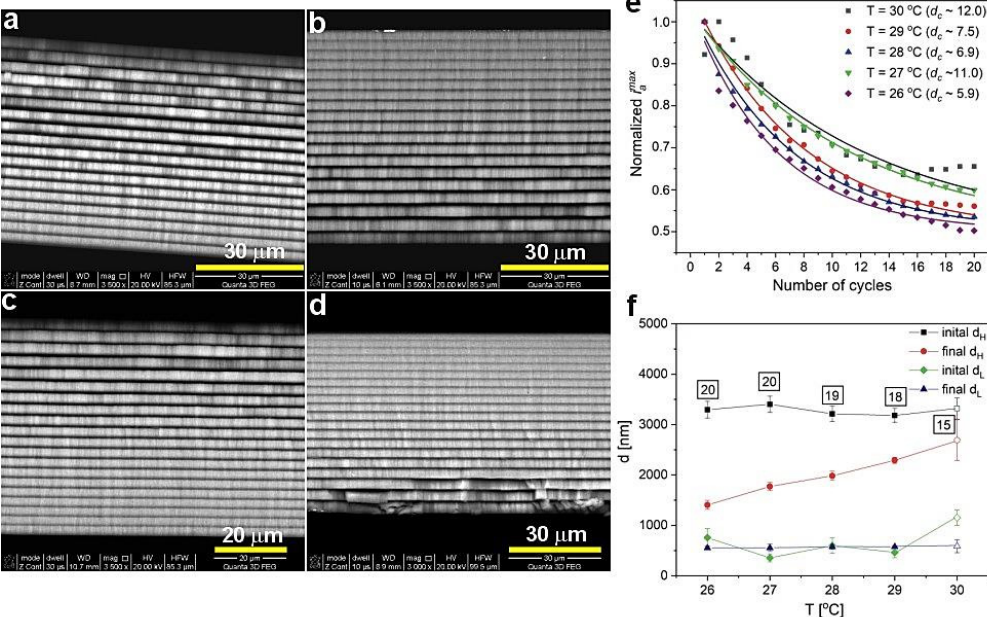
Figure 2. BSE images of PAA-29 °C ( a ), PAA-28 °C ( b ), PAA-27 °C ( c ), PAA-26 °C ( d ) samples; normalized i amax as a function of number of cycles ( e ); initial and final thickness of d H and d L layers as a function of anodizing temperature ( f ); the number in black squares indicate the number of d H + d L pairs in the respective samples (the normalized i amax and layer thickness for the PAA-30 °C sample [27] are also shown for comparison).